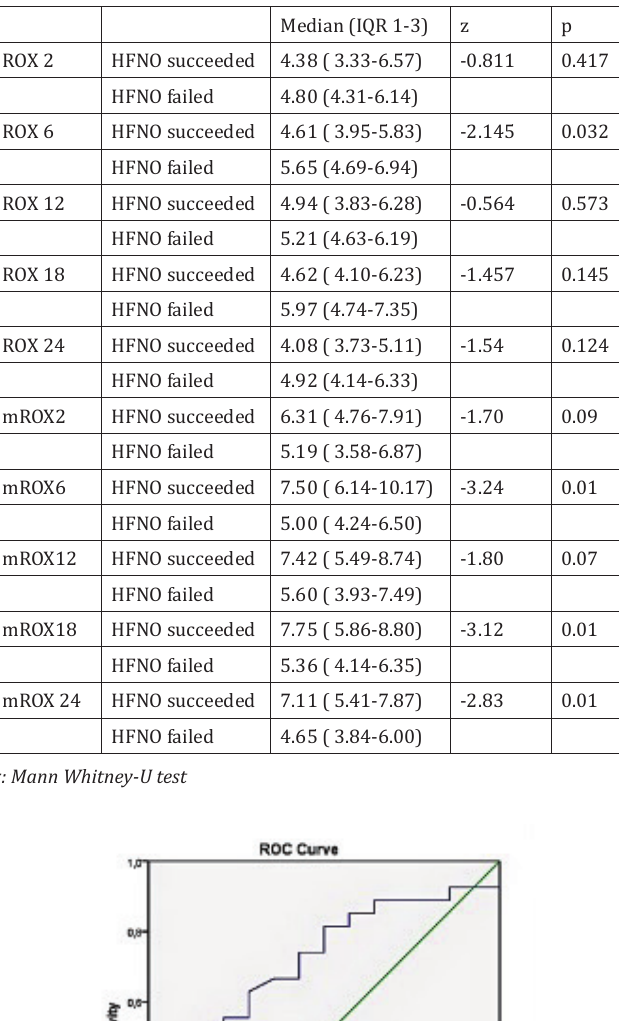
Table 2 ROX and mROX indicies